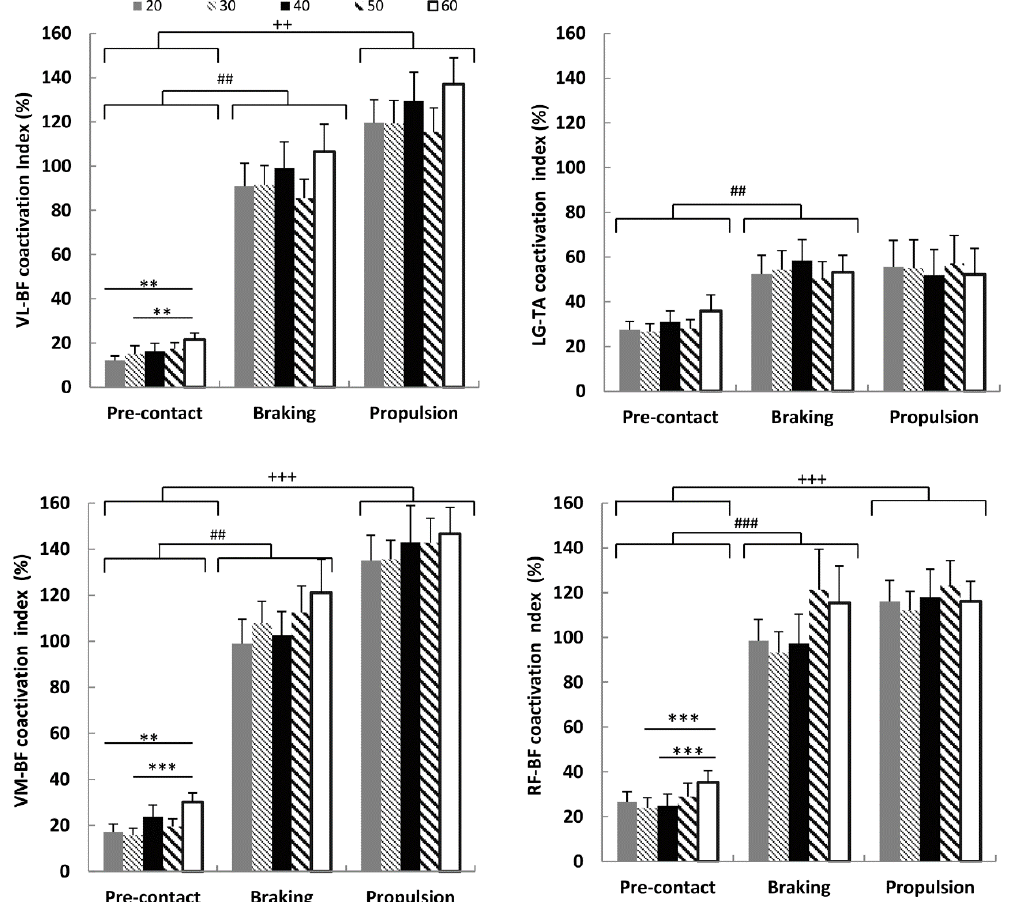
Figure 3. Mean values (SE) of the coactivation index are reported in three di ff erent phases (pre-contact, braking, propulsion) of the drop jump (DJ) and from five drop heights (20, 30, 40, 50 and 60 cm). The coactivation index is reported for the following pairs of muscles: vastus lateralis and biceps femoris (VL–BF), lateral gastrocnemius and tibialis anterior (LG–TA), vastus medialis and biceps femoris (VM–BF), rectus femoris and biceps femoris (RF–BF). * Statistical significance among the drop heights within each phase (** p < 0.01; *** p < 0.0001). # Statistical significance between the pre-contact phase and braking phase (average values) ( ## p < 0.01; ### p < 0.0001). + Statistical significance between the pre-contact phase and propulsion phase ( ++ p < 0.01; +++ p <